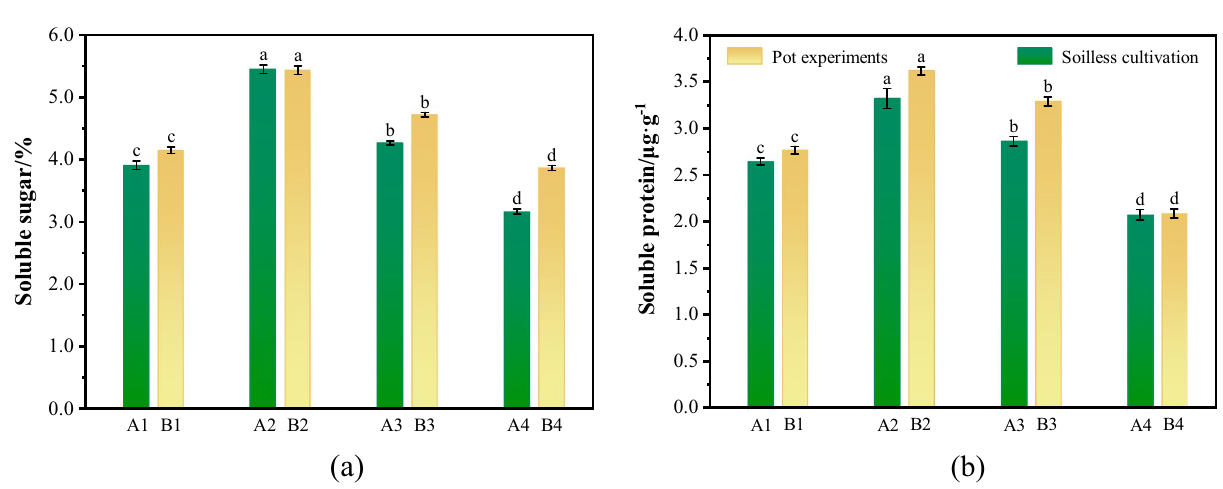
Figure 2. Effects of mine water on plant physiological characteristics (One-Way ANOVA, α = 0.05). ( a ) Soluble sugar; ( b ) soluble